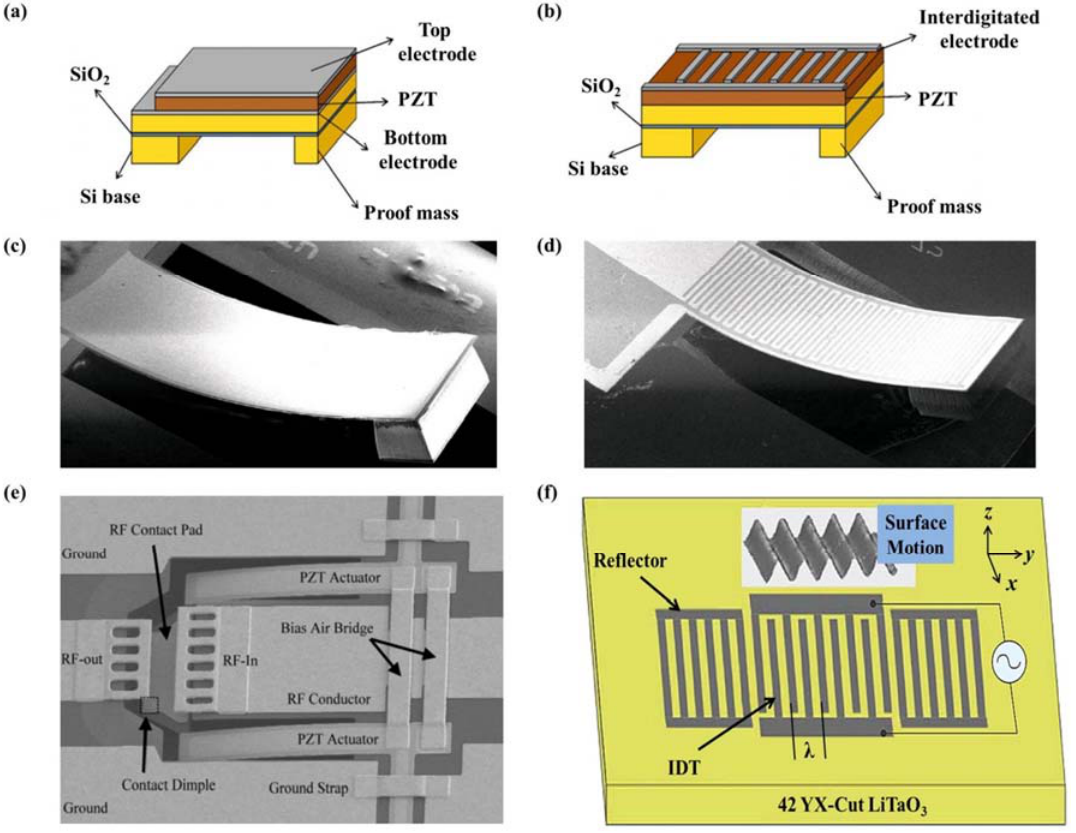
Figure 24. Schematic diagram of the piezoelectric microelectronics and microelectromechanical systems (MEMS) generators: ( a ) {3–1} mode configuration; and ( b ) {3–3} mode configuration (from Lee et al. [504]). SEM photograph of the